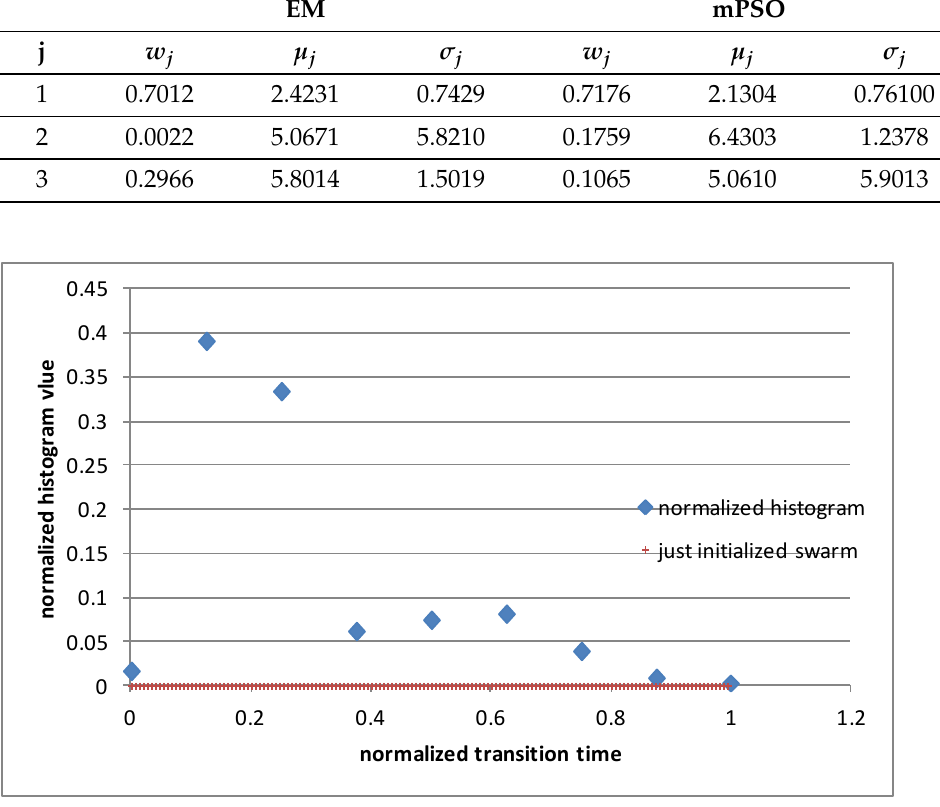
Figure 16. Example of just initialized swarm is distributed